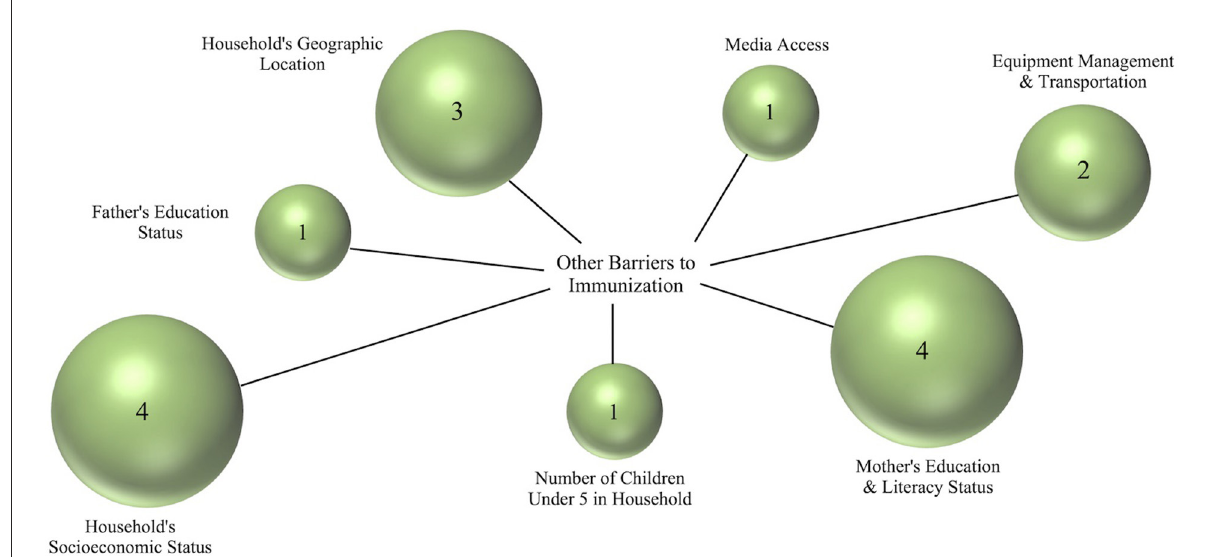
FIGURE2 Frequency of reported barriers to immunization other than sex. Such factors were qualitatively assessed and presented based on how many articles included in the full-text screening mentioned each factor. Bubble size corresponds to the number of articles that mentioned each factor, as does the number inside each bubble. Household’s socioeconomic status and female education/literacy status were the two factors listed most frequently in such articles. Media access refers to an individual’s access to information (including information about vaccinations) via the internet; Equipment management and transportation refers to managing refrigeration, gasoline, and the transportation of materials used for immunizations to health centers.